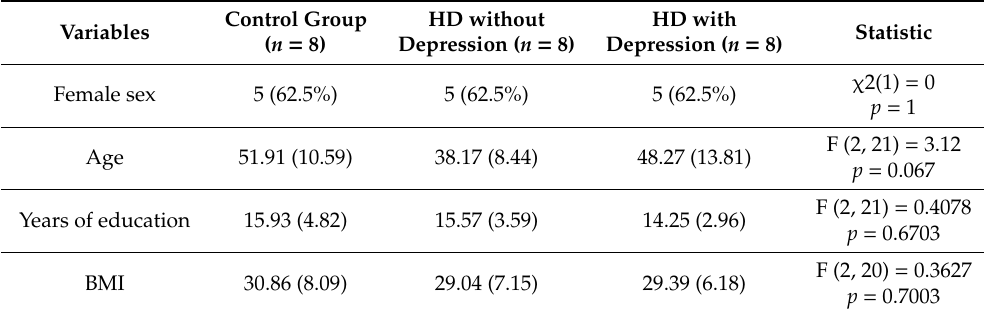
Table 1. Demographic variables of the subjects enrolled in this